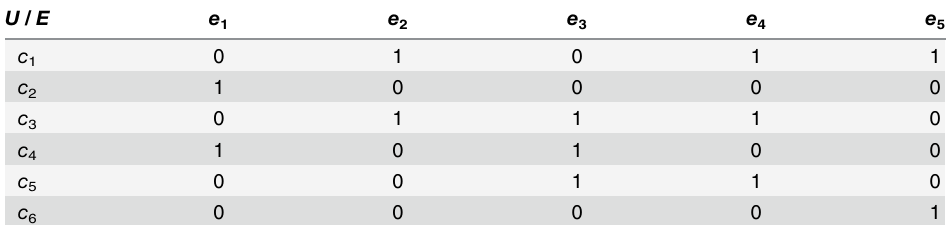
Table 1. Tabular Representation of Soft set ( F , E ). U / E e